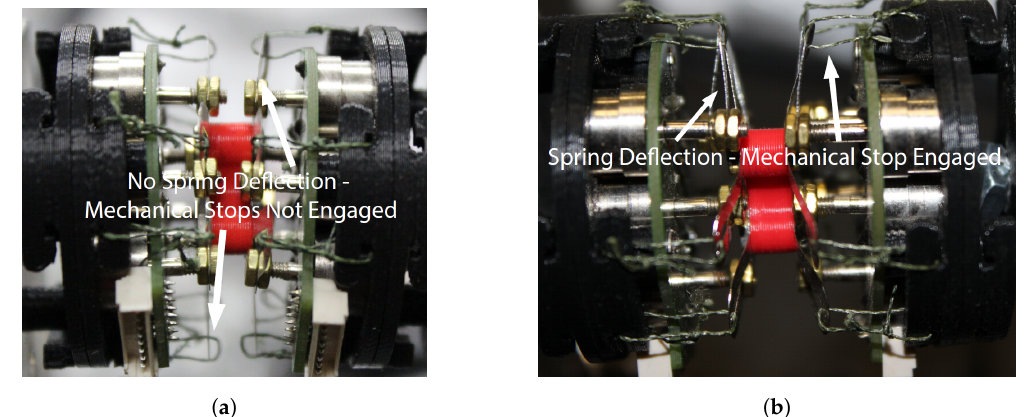
Figure 4. Demonstration of straps engaged with leaf-spring: ( a ) mechanical stop not engaged; and ( b ) mechanical stop